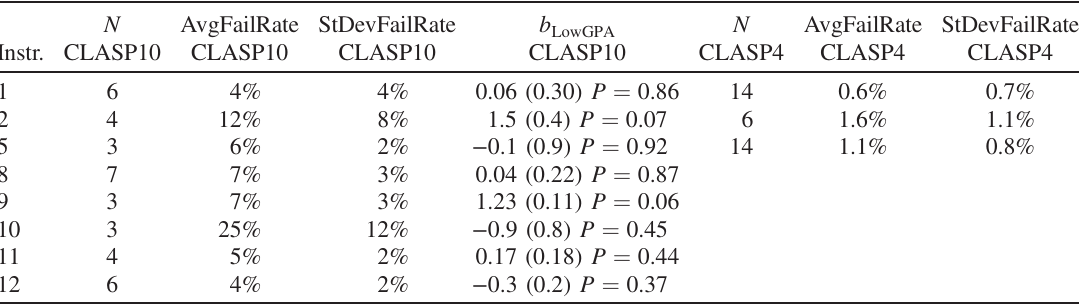
TABLE IV. Eight instructors used the CLASP10 grade scale in at least 3 courses. Instructors 1, 2, and 5 are also represented in Table III. N is the number of classes that the instructor taught under the specific grade scale over the time period of the study. AvgFailRate is the average, over classes, of the fraction of students in a class who had grades less than C − and StDevFailRate is the standard deviation, over classes, of the fraction of students in a class who had grades less than C − . The variable b is the linear coefficient from Eq. (A2), with its standard error and LowGPA P value, for a regression limited to that instructor ’ s classes. The relevant numbers from CLASP4 courses for the three instructors from Table III are also